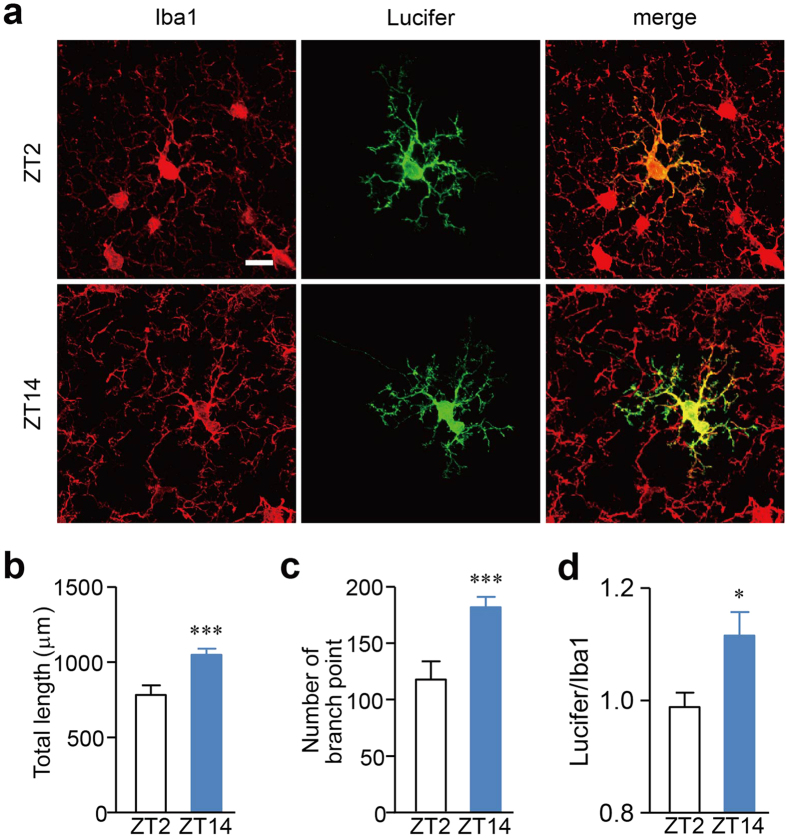
The diurnal variation in the morphological and dynamic behavior of the microglial processes.(a) The diurnal morphological variation in the intracellularly labeled cortical microglia. The Iba1-stained microglia (Iba1), intracellularly labeled microglia (lucifer) and their merged CLMS images. Scale bar: 10 μm. (b,c) The mean total length of the processes (b) and branch points (c) of the intracellularly labeled microglia at ZT2 and ZT14. The data are presented as the mean ± S.E.M. (N = 3 mice, n = 12–13 microglia each). A two-tailed unpaired t-test; ***p = 0.0005 (b), ***p = 0.0005 (c,d) The mean ratio of the total microglial process length of Iba1-immunostaind microglia to the intracellularly labeled microglia. The data are presented as the mean ± S.E.M. (N = 3 mice, n = 5 microglia each). A two-tailed unpaired t-test; p = 0.0325.